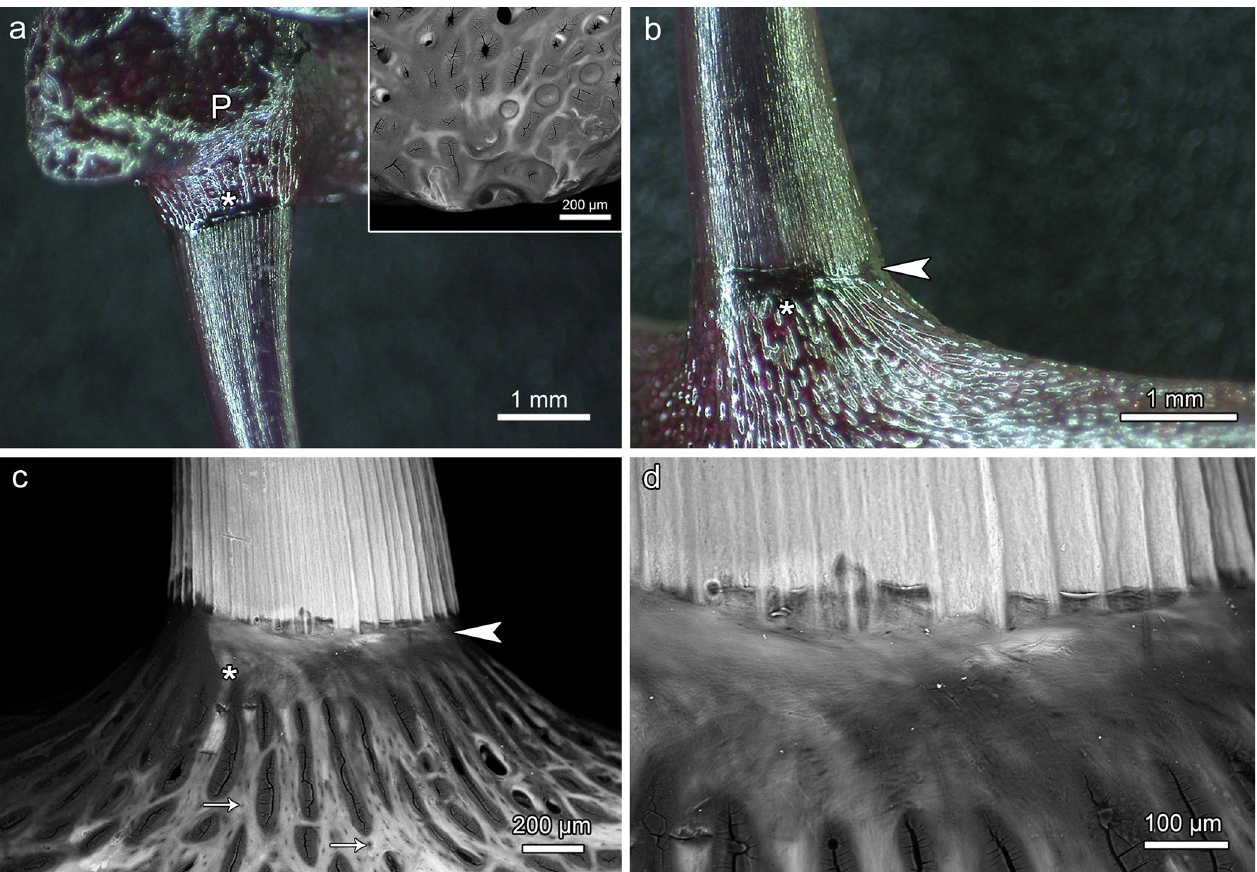
Fig 2. Oral jaw teeth and supporting bone in Anoplogaster cornuta . (a) Basal portion of right first premaxillary tooth, bone of attachment (asterisk) and premaxillary bone (P), medial view. The cleared and stained specimen shows intense staining of dentin and bone by alizarin red S. Insert: SEM-BSE image of the empty socket of the second premaxillary tooth, lateral view. (b) Transition zone between basal portion of left first dentary tooth and bone of attachment (asterisk). Arrowhead: Collar of mineralized collagen fibers. (c) SEM-BSE image of transition zone between basal portion of left second dentary tooth and bone of attachment (asterisk), lateral view. Note regular longitudinal corrugation of the tooth surface, collar of mineralized collagen fibers (arrowhead), and presence of numerous osteocyte lacunae (arrows) in the supporting dentary bone compared to lack of such lacunae in the bone of attachment. (d) Higher magnification of the transition zone between basal tooth portion and bone of attachment with collar of mineralized collagen